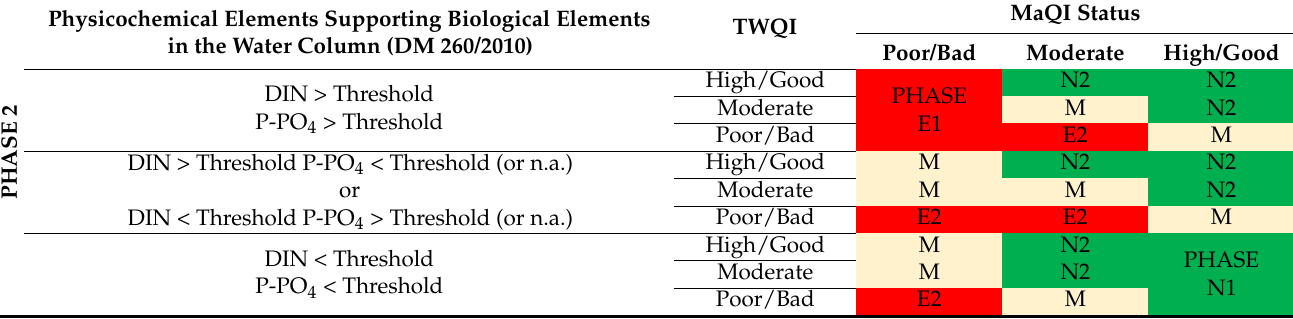
Table 3. Application of the TWEAM in phase 2 and possible outcomes: integration of nutrients according to MD 260/2010, MaQI, and TWQI.